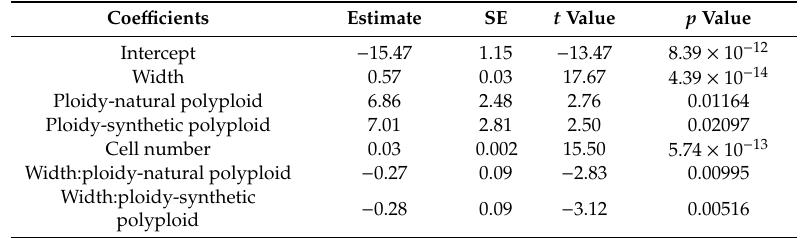
Table 3. Linear model results for corolla tube circumference~width + ploidy + width: ploidy + cell